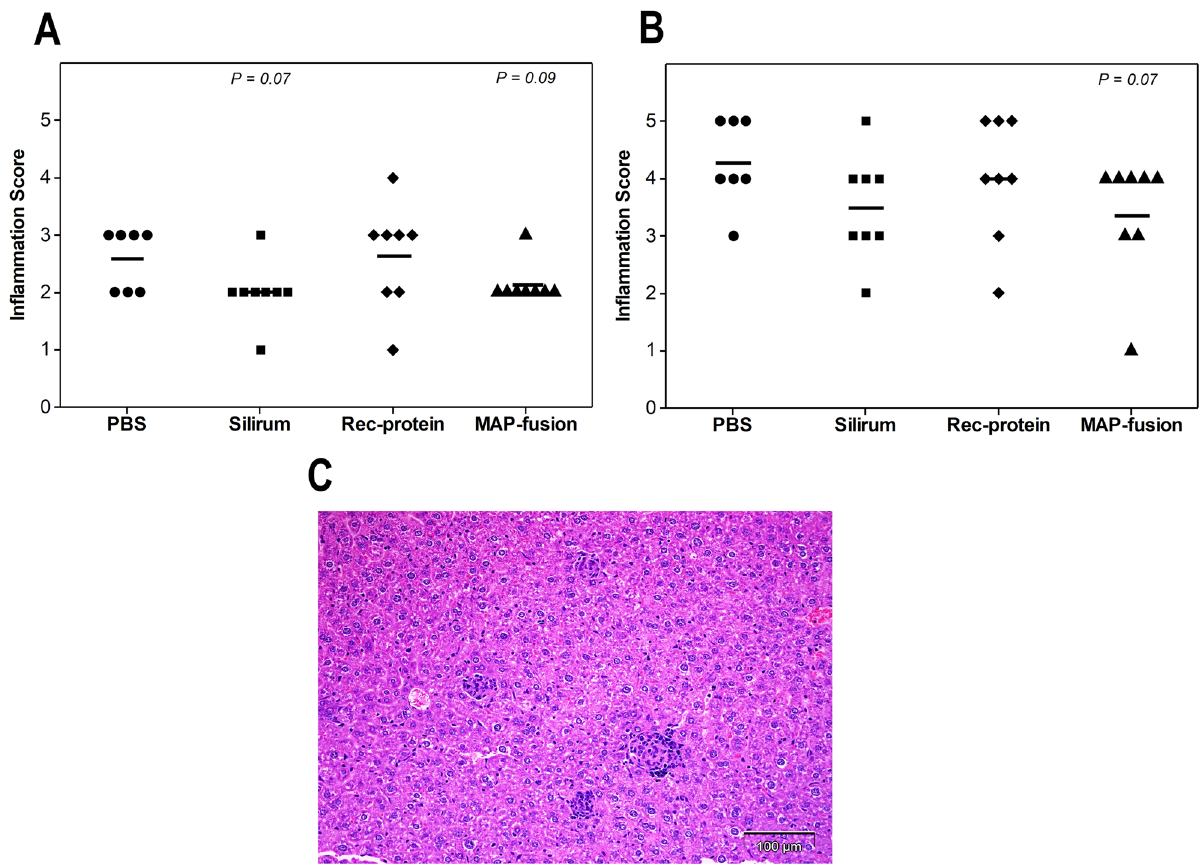
Figure 6. Histopathological examination of the mice post-challenge with MAP. The tissue sections were stained with haematoxylin and eosin and Ziehl–Neelsen stains and examined by light microscopy. Small (up to 25 µm in diameter) and large granuloma (up to 100 µm in diameter) counts were measured in the liver at 8 and 16 weeks post-challenge. ( A ) The inflammatory score ranged from 0 to 5 based on the total granuloma score, with inflammatory score of 1: very low granuloma score to 5: high granuloma score. The total granuloma score was the sum of the scores for the small and large granulomas. Small granuloma (up to 25 µm in diameter) containing predominantly small lymphocytes were recorded as 1 and large granulomas (up to 100 µm in diameter) containing predominantly epithelioid macrophages as 2. Mean inflammation score is represented by horizontal lines. ( B ) A photograph of liver section was obtained from PBS vaccinated mice showing small and large granulomas randomly dispersed in the liver. Bar represents 100